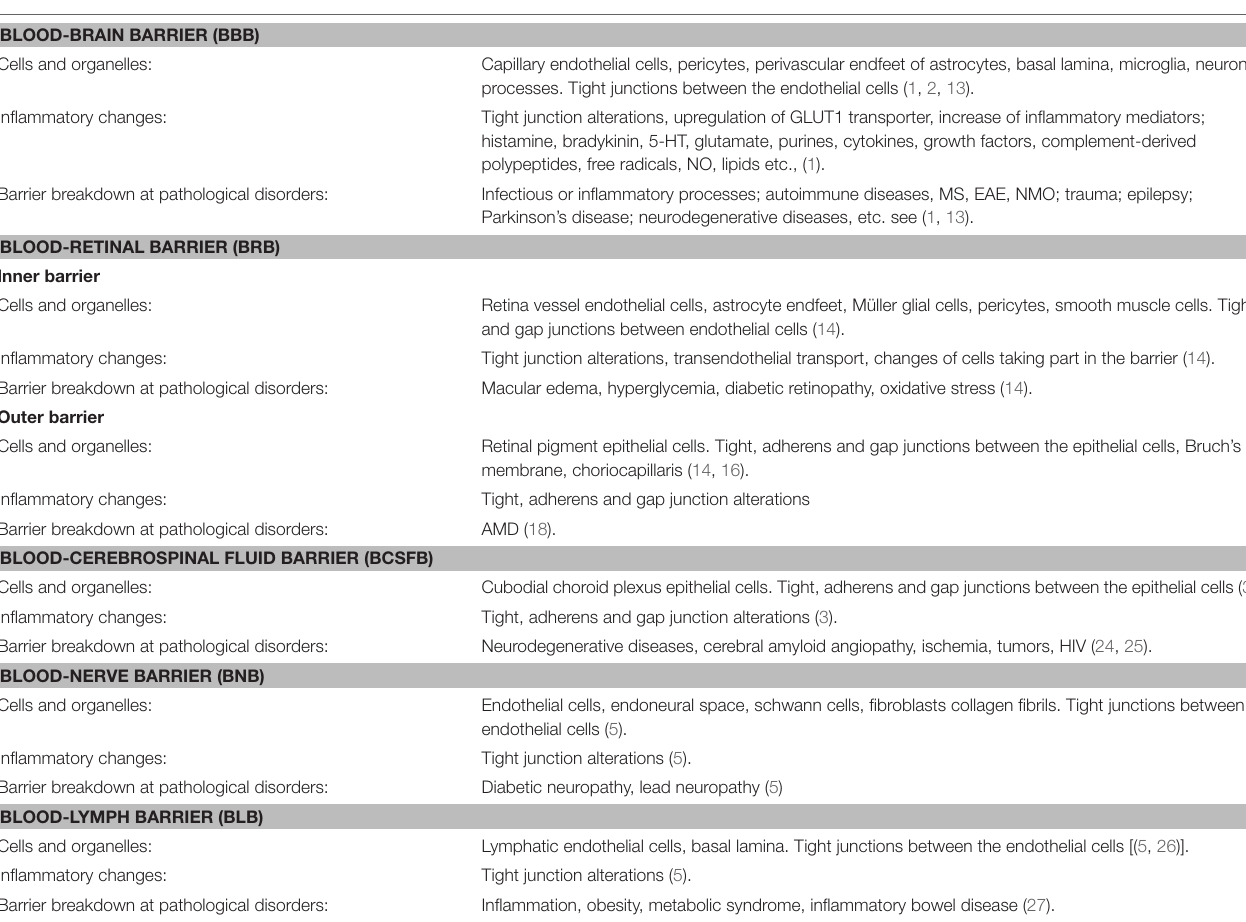
TABLE 1 | Characteristics for the blood-brain barrier, blood-retinal barrier, blood-nerve barrier, blood-lymph barrier and blood-cerebrospinal fluid barrier in physiological and inflammatory conditions. BLOOD-BRAIN BARRIER